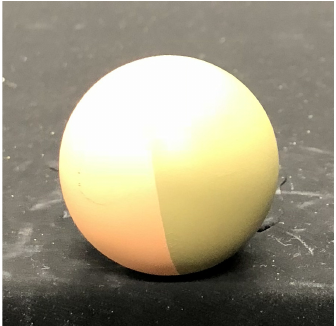
Figure 13. A spherical object with two different colors is used for evaluation since we know the mathematically true surface normal of the